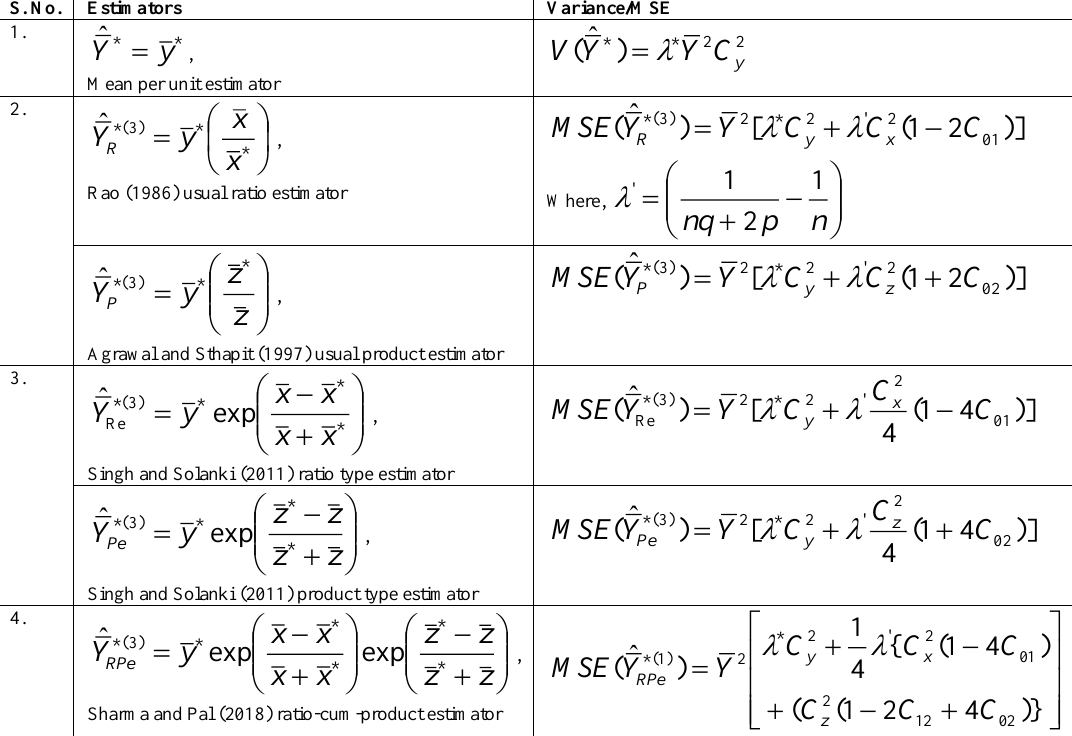
Table 5. Competing estimators under third strategy of non-response along with their MSEs S. No. Estimators Variance/MSE